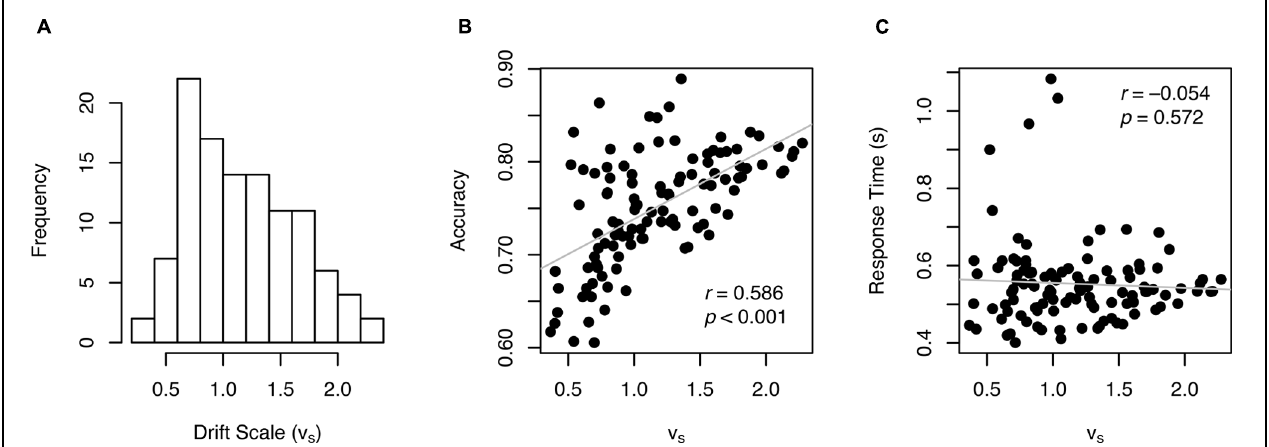
FIGURE 4 | Individual drift scale ( v S ) (A) and their relationship with other variables